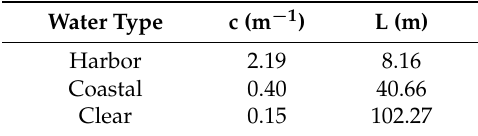
Table 1. Theoretical longest communication distance for three water types.